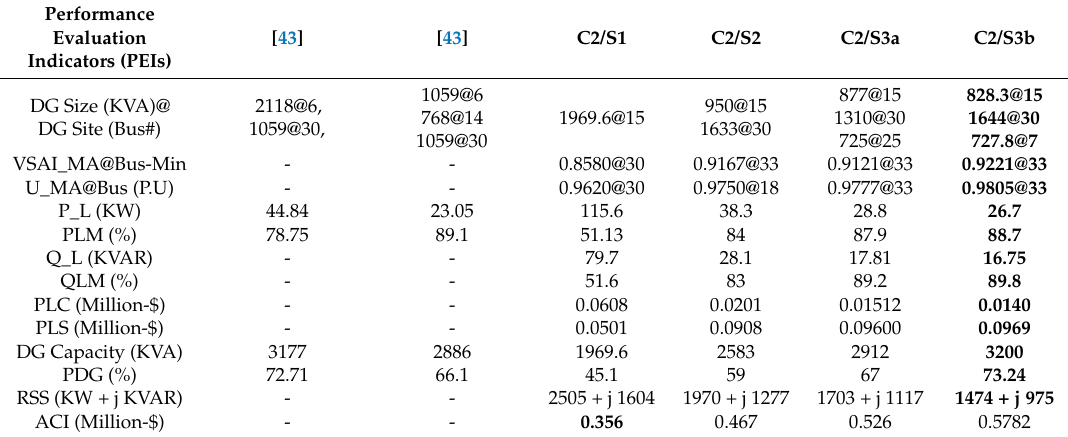
Table 8. Comparisons of results with various scenarios of Case 2 for 33-Bus test system (DG @ pf = 0.85 ±